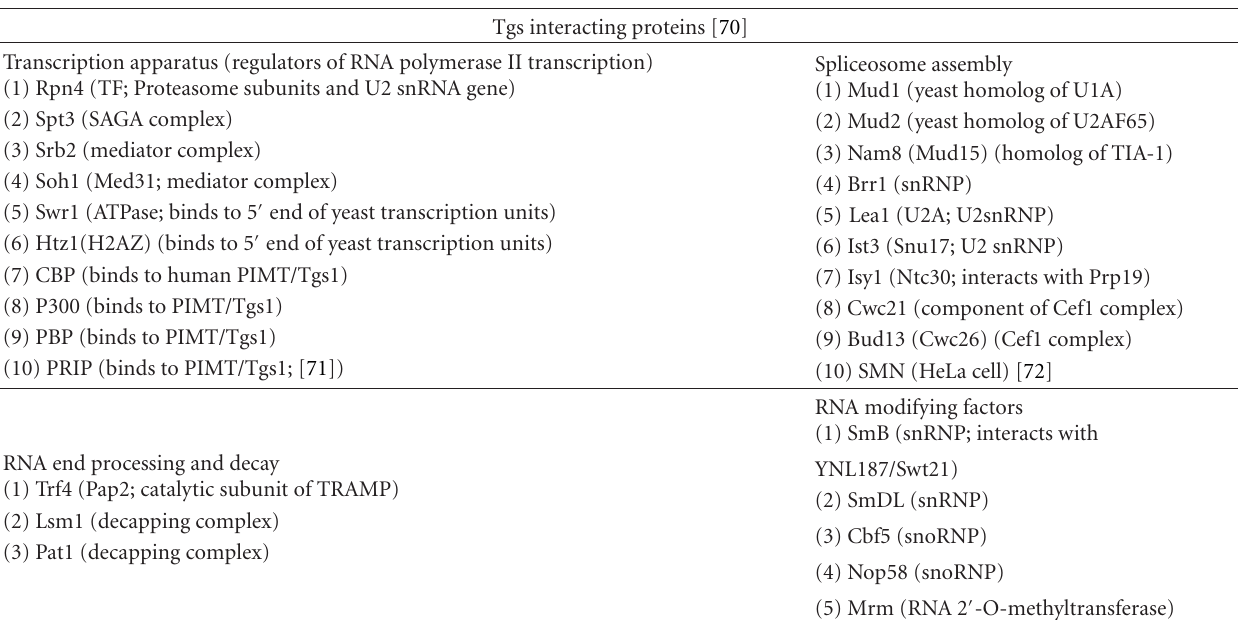
Table 12: Tgs1 interacting proteins [70–72]. The Tgs1 (trimethylguanosine synthase 1) interacting proteins are listed. It is interacting with proteins involved in many aspects of RNA metabolism such as transcription, spliceosome assembly, maturation, and modification. Tgs interacting proteins